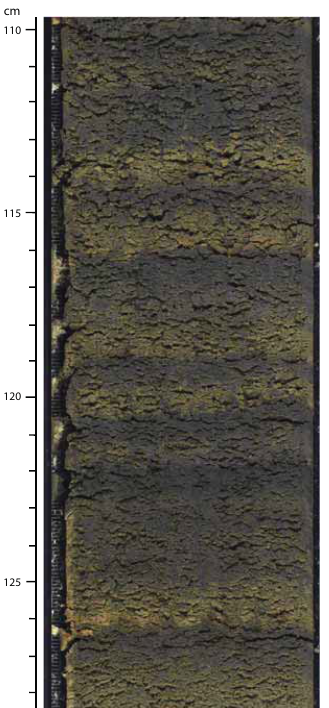
Figure 5.Example of a core section from Holocene diatomaceous ooze, Site U1357. Note the distinct seasonal